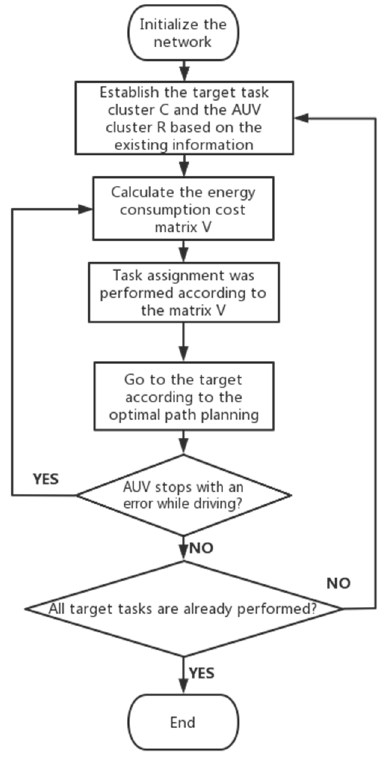
Figure 2. Flow chart of the AE algorithm.